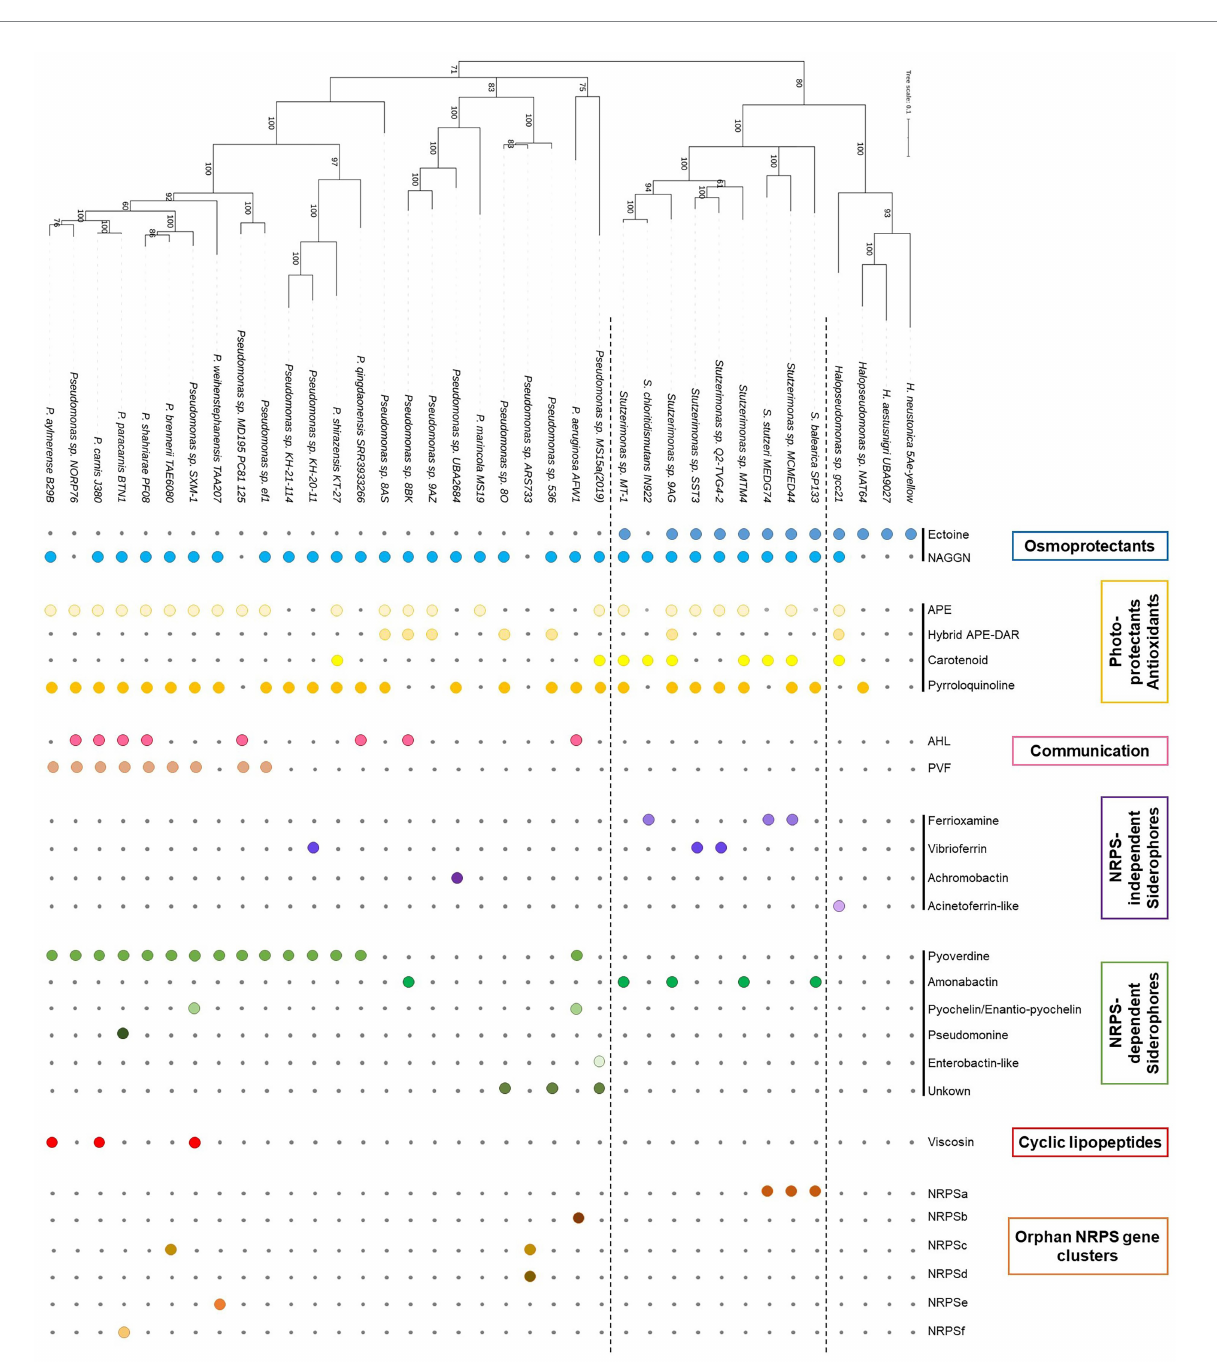
Cell-to-cell communication Quorum sensing (QS) genes were only found in Pseudomonas and were absent from Halopseudomonas and Stutzerimonas genomes. All LuxI homologs identified in this study are clustering with known Pseudomonas Table S8;